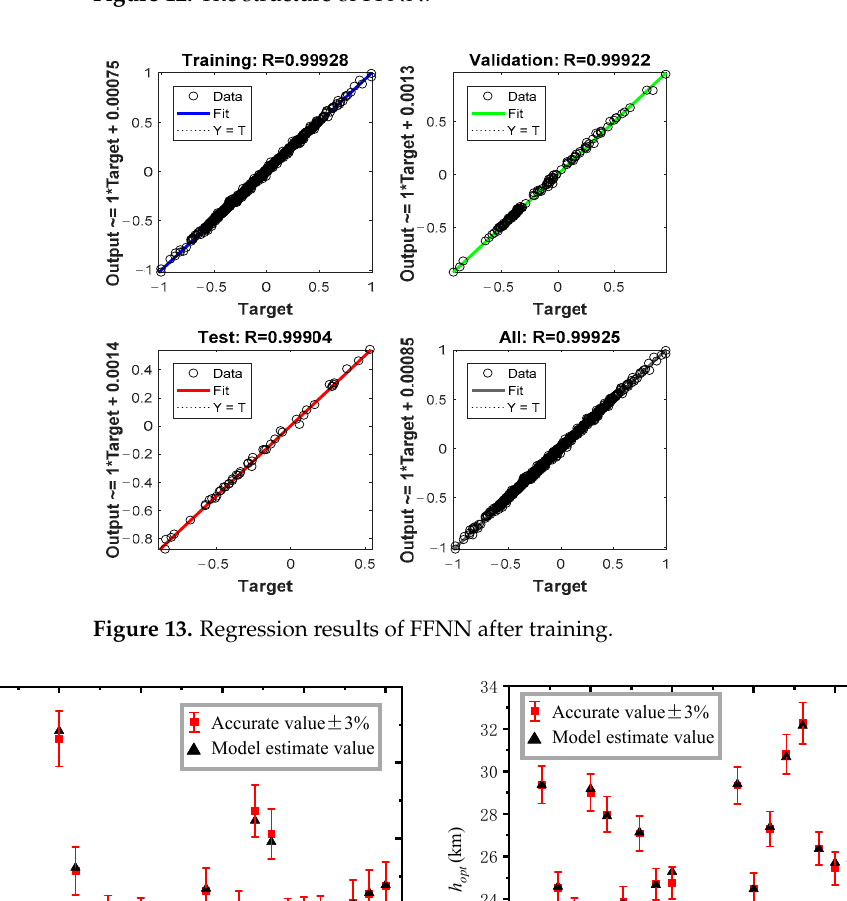
Figure 12. The structure of FFNN.